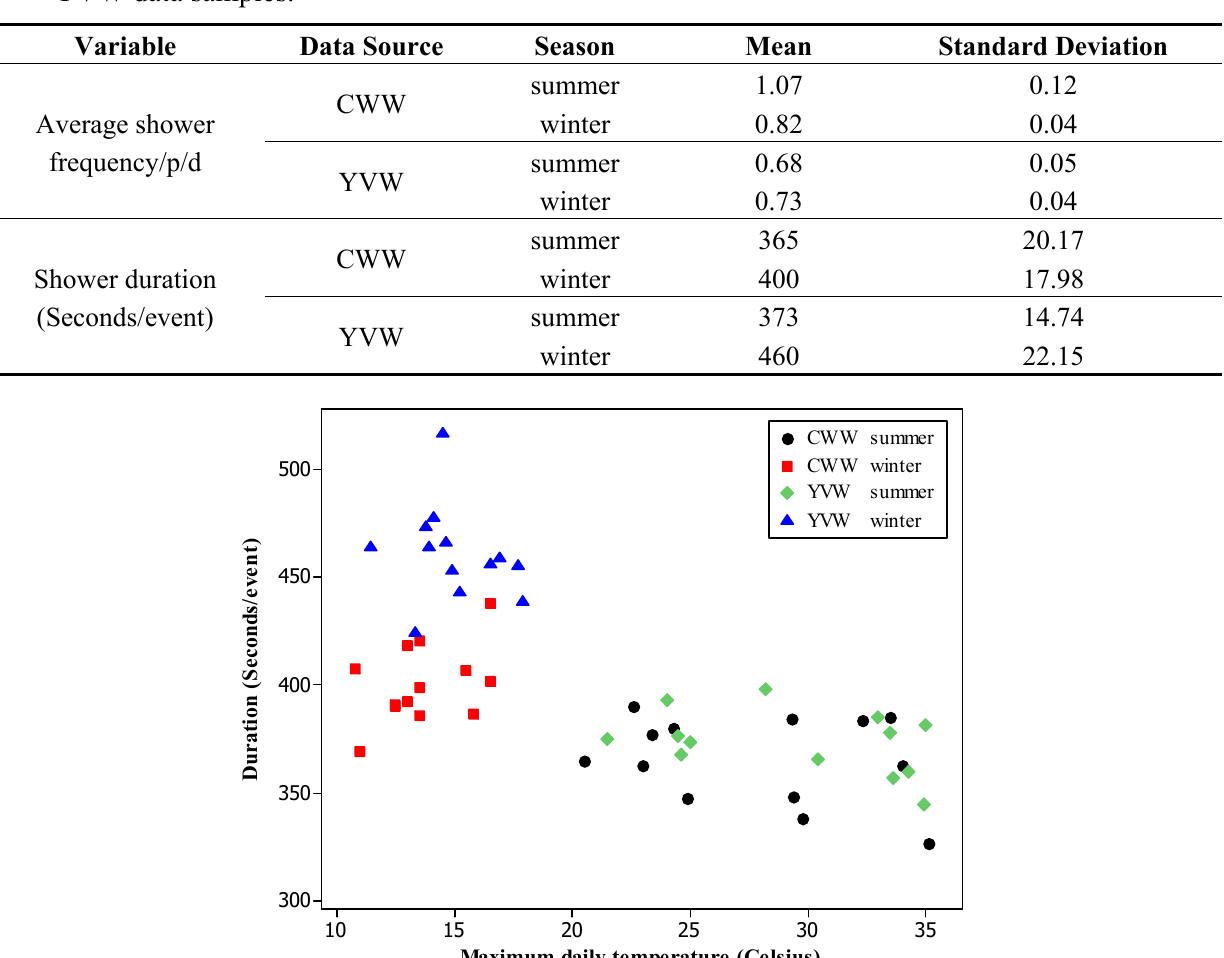
Figure 3. Scatter plot of average shower duration (seconds/event) and maximum daily temperature. OLS Regression analysis between average shower duration (seconds/event) and maximum daily temperature (°C) shows a negative correlation between these two variables (Table 7). A p value lower than 0.05 suggests that the relationship is statistically significant (Table